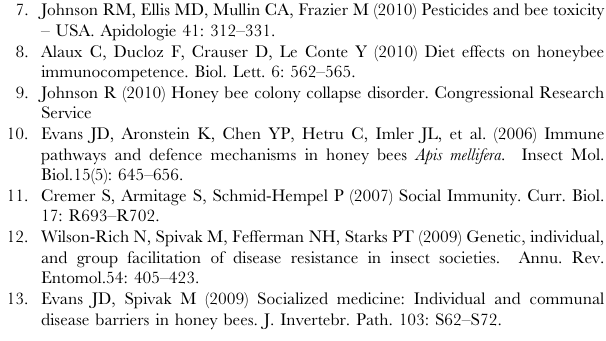
Figure S1 R script for comparative metabolomic anal- ysis. This script is a conservative, open source data analysis procedure for metabolomics experiments that use a ‘composite’ quality control sample, as described in the results subsection ‘‘Honey bees collect resin from balsam poplar and eastern cottonwood.’’ (DOC)